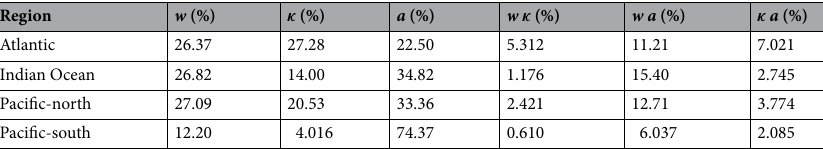
Table 1. Measure of the contribution of respective parameter uncertainties to the variance (spread) within the ensemble of projected changes of the local oxygen minima. The units are %, calculated using the method of Sobol 20 . The values refer to spatial averages of the regions defined in Figure